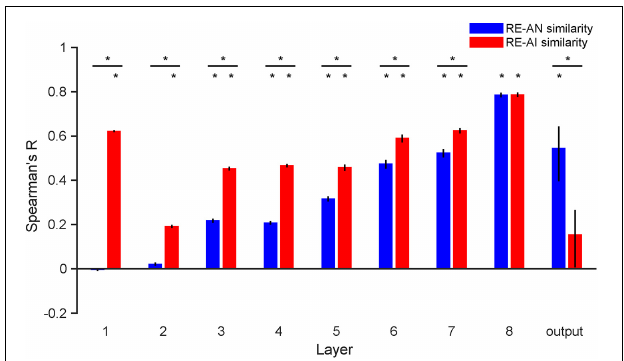
FIGURE 5 | RE-AN and RE-AI similarities across layers in AlexNet. the RE-AN similarity increases and the RE-AI similarities decline along the processing hierarchy. The RE-AN similarities are not higher than the RE-AI similarities in all representational layers (i.e., layer 1–7). Error bars indicate 95% bootstrapped confidence intervals (see